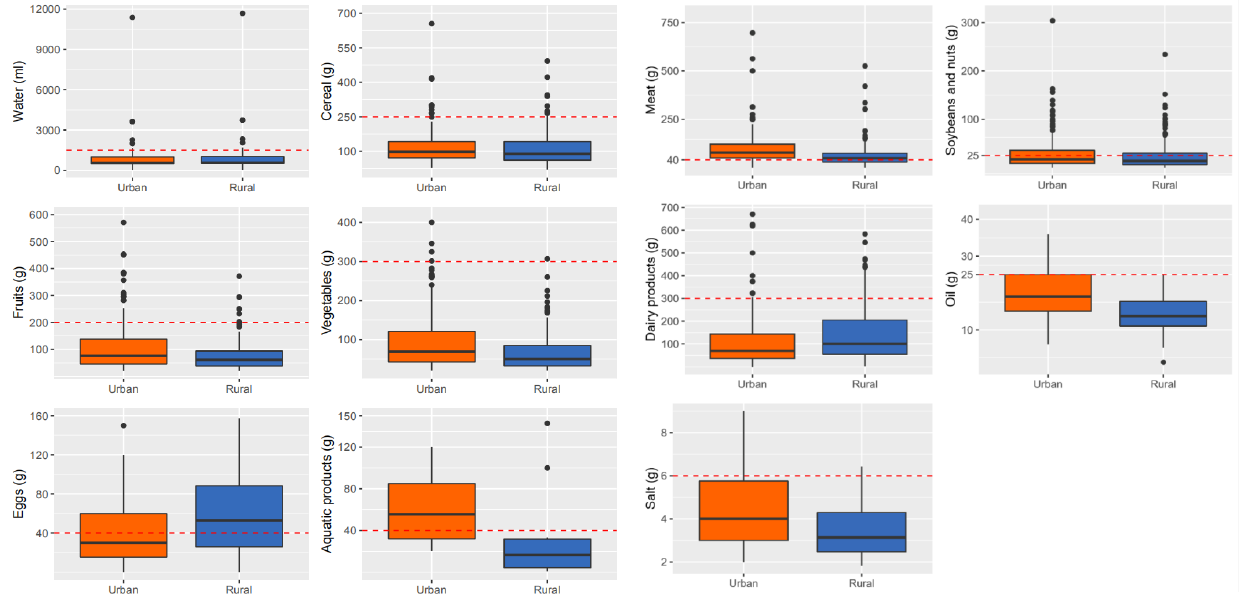
Figure 3. Dietary intakes of urban and rural Tibetan local residents.